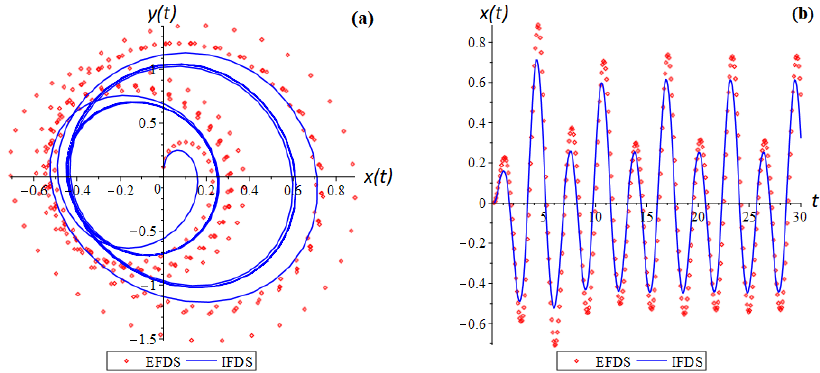
Figure 5. Phase trajectory ( a ) and waveform ( b ) for the Cauchy problem (1) obtained by explicit (7) and implicit (8)